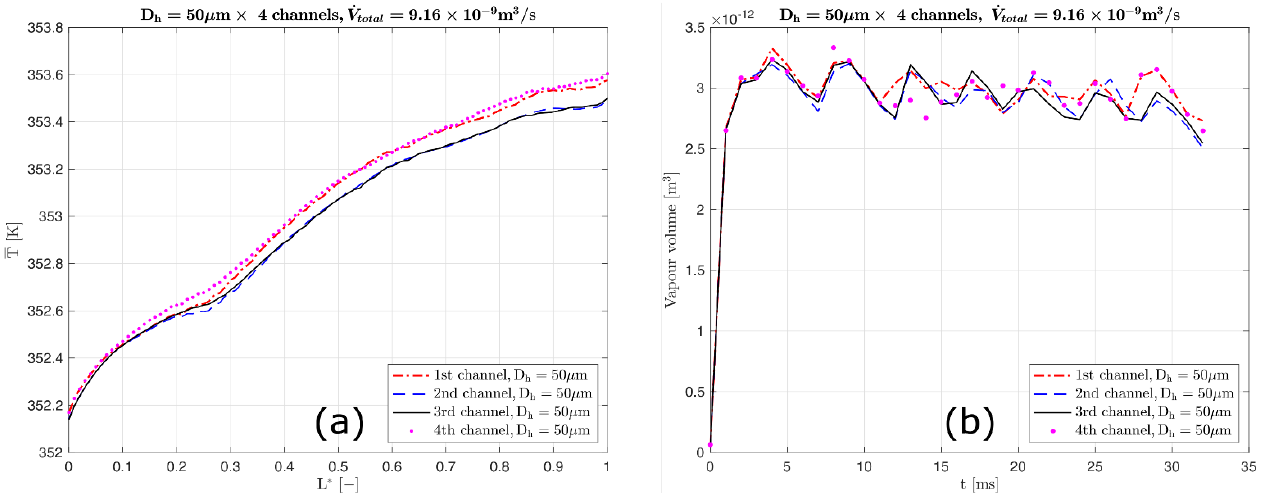
Figure 9. For 𝑞 ′′ = 50 kW/m 2 and 𝐺 = 600 kg m 2 s⁄ . ( a ) Comparison of time-averaged temperature 𝑇̅ measured in the meniscus along each channel over L*. ( b ) Comparison of the volume vapour of each channel over time t.